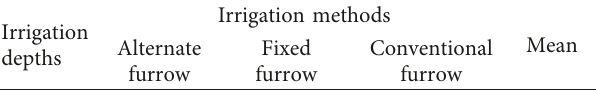
Table 2: Sesame yield response to deficit irrigation during the main cropping season in 2013 and 2015. Irrigation furrow Yield (kg/ha) response to irrigation amount and methods during the main cropping season in